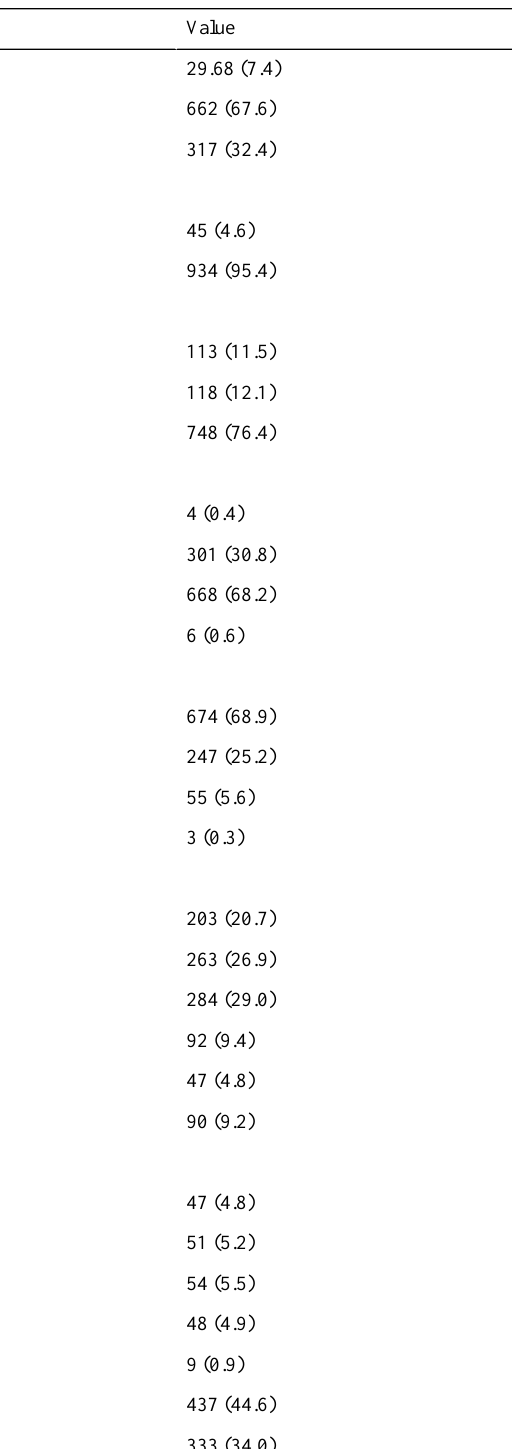
Table 1. Demographic characteristics of the study participants